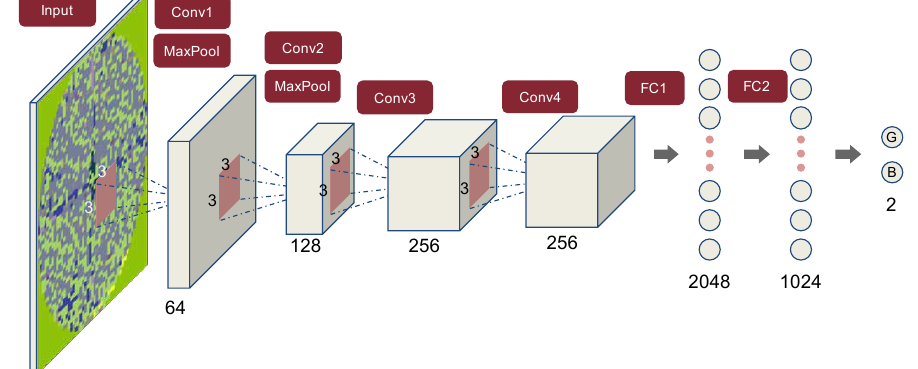
Figure 12. Convolutional neural network architecture used in this